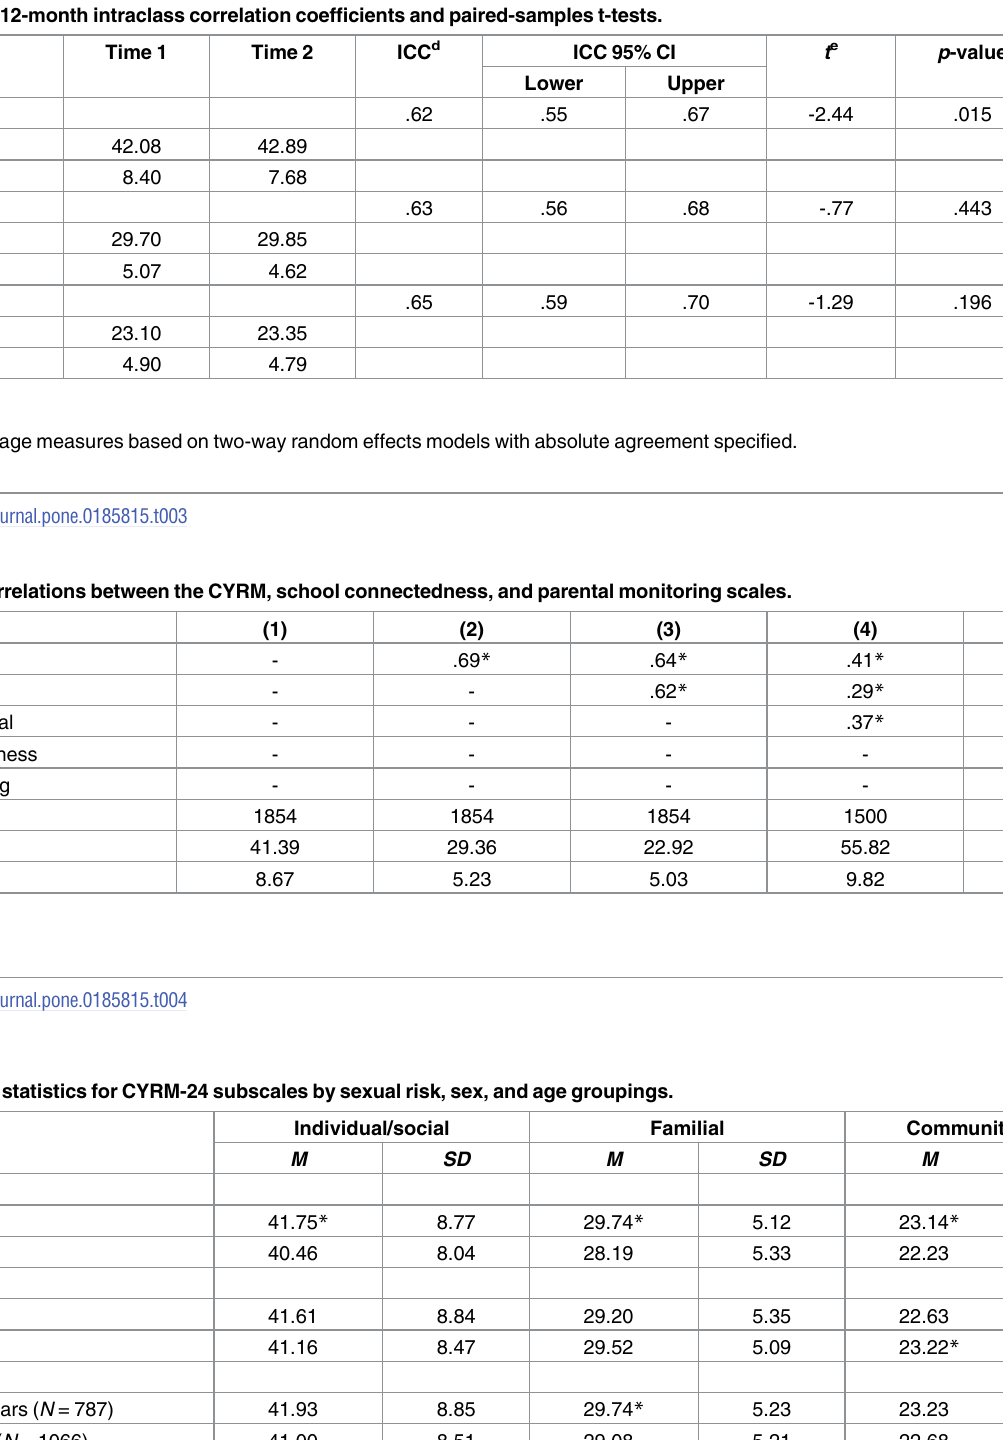
Table 3. Baseline to 12-month intraclass correlation coefficients and paired-samples t-tests.